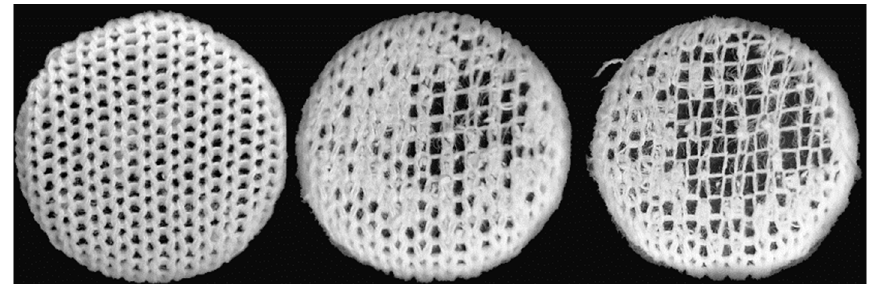
Figure 11. Surface appearance of the untreated heel plain knit sample MD-Ai-A, before, during and at the end of the abrasion resistance test (determined at 0, 8000 and 12,000 abrasion rubs). The endpoints reached in the plain knits sampled from the heels and soles of the tested socks, are shown in Figure 12a, b. The untreated sock knits made from modal ring spun yarns exhibited better abrasion resistance than those made from rotor and air-jet modal spun yarns, which was particularly noticeable in the sock heel (Figure 12a). Ring